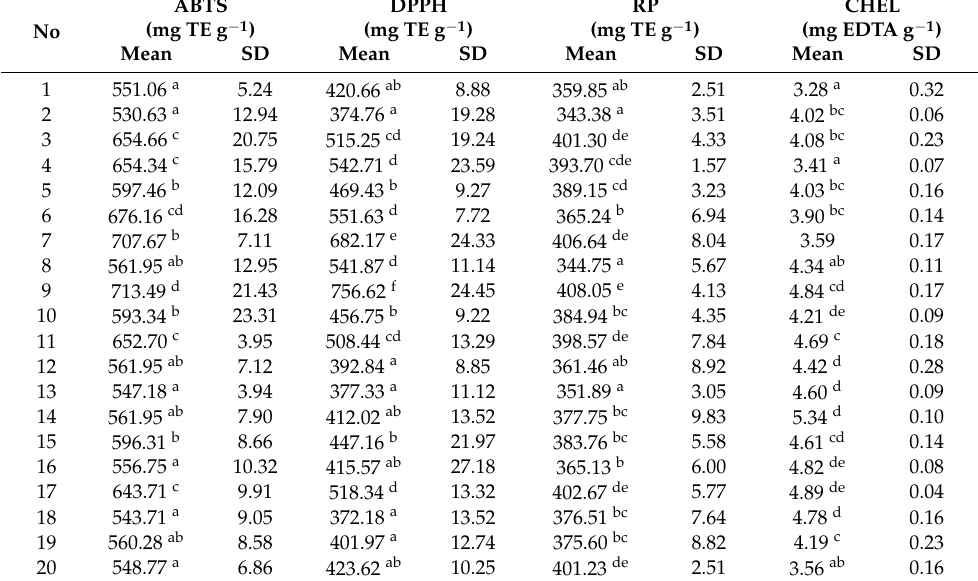
Table 2. Antioxidant activity parameters of leaf extracts from bearberry plants collected in heathland populations (No 1–10) and in pine forest populations (No 11–20). For each site, data are mean and SD.